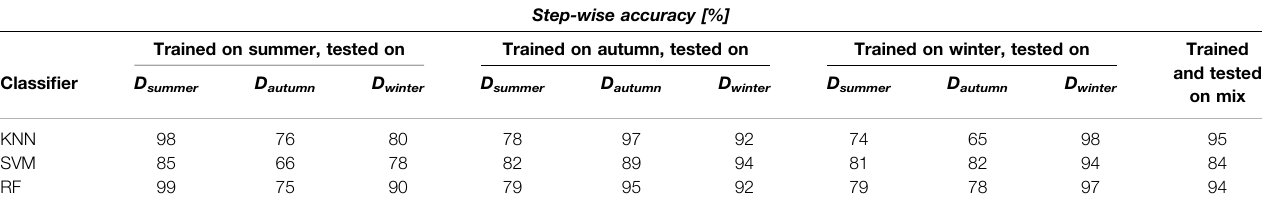
TABLE 3 | Terminal state classi fi cation. We used repeated 2-fold cross-validation, i.e., 50% of data was selected for training and 50% for testing which was repeated fi ve times. Highest accuracy for each scenario marked in bold.